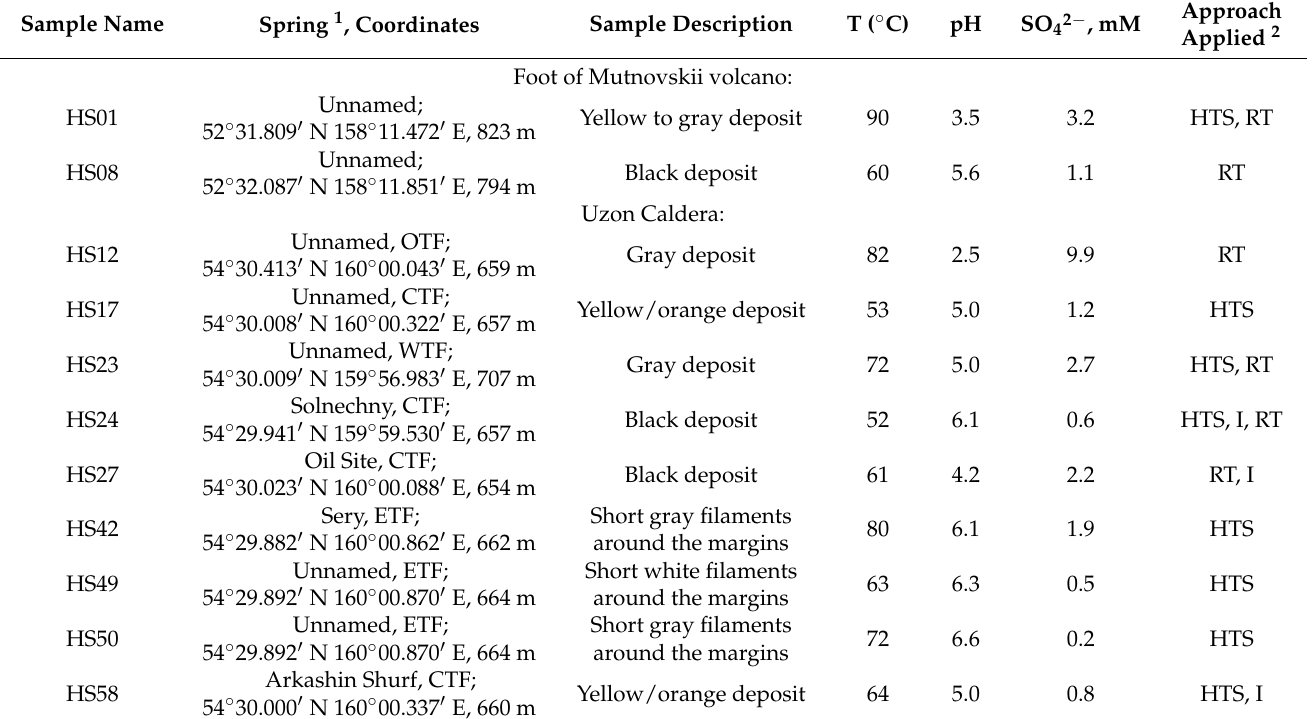
Table 1. Main characteristics of studied Kamchatka hot